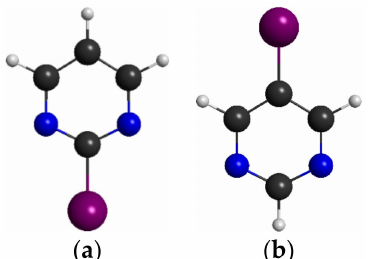
Figure 1. Molecular structure of ( a ) 2-bromopyrimidine, and ( b ) 5-bromopyrimidine. Carbon atoms in black, hydrogen in white, nitrogen in blue, and bromine in